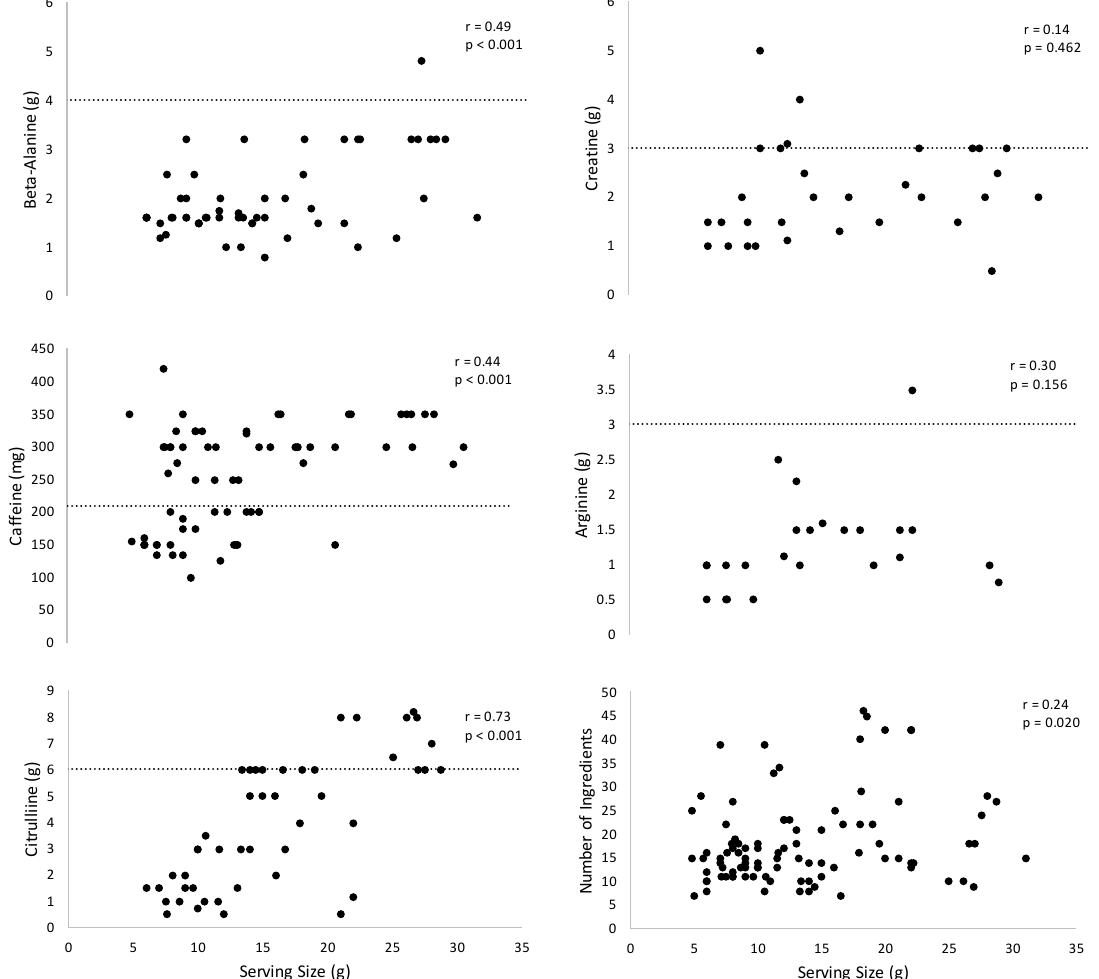
Figure 1. The relationships for beta-alanine ( n = 56), caffeine ( n = 70), citrulline ( n = 47), creatine ( n = 31), arginine ( n = 24), and number of ingredients ( n = 94) versus serving size for the pre-workout supplements. Dashed line represents the minimum suggested ergogenic quantity.